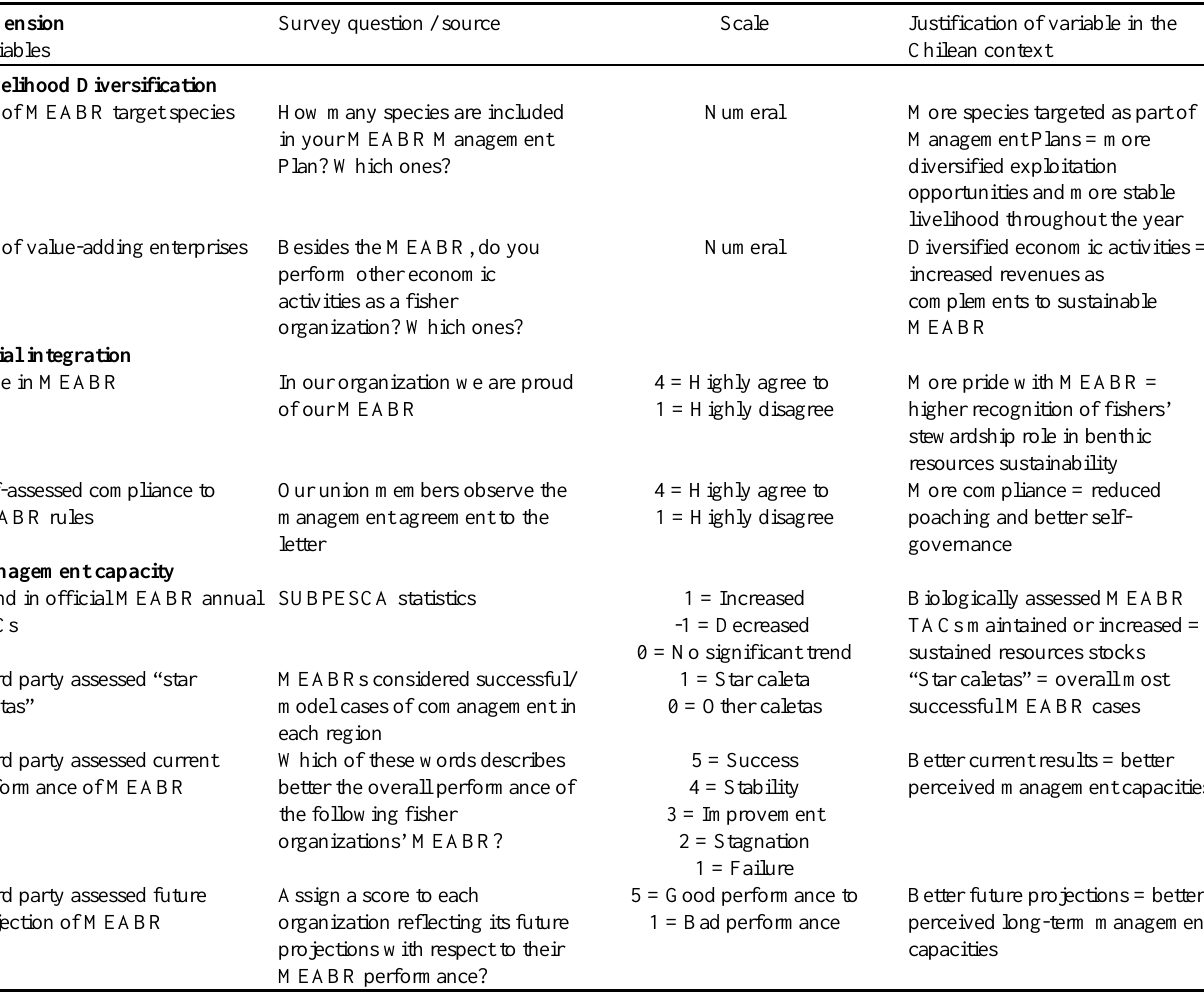
Table 1 . Comanagement performance dimensions, variables, and indicators for the Management and Exploitation Areas for Benthic Resources (MEABR)